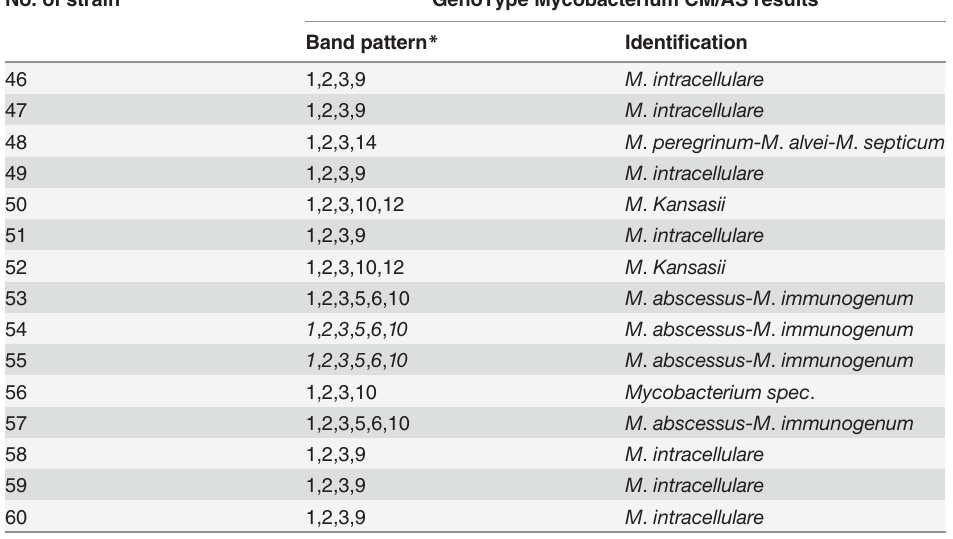
Table 2. The distributions of NTM identi fi ed by GenoType Mycobacterium CM/AS assay. Mycobacterium species Positive specimens No. Percent